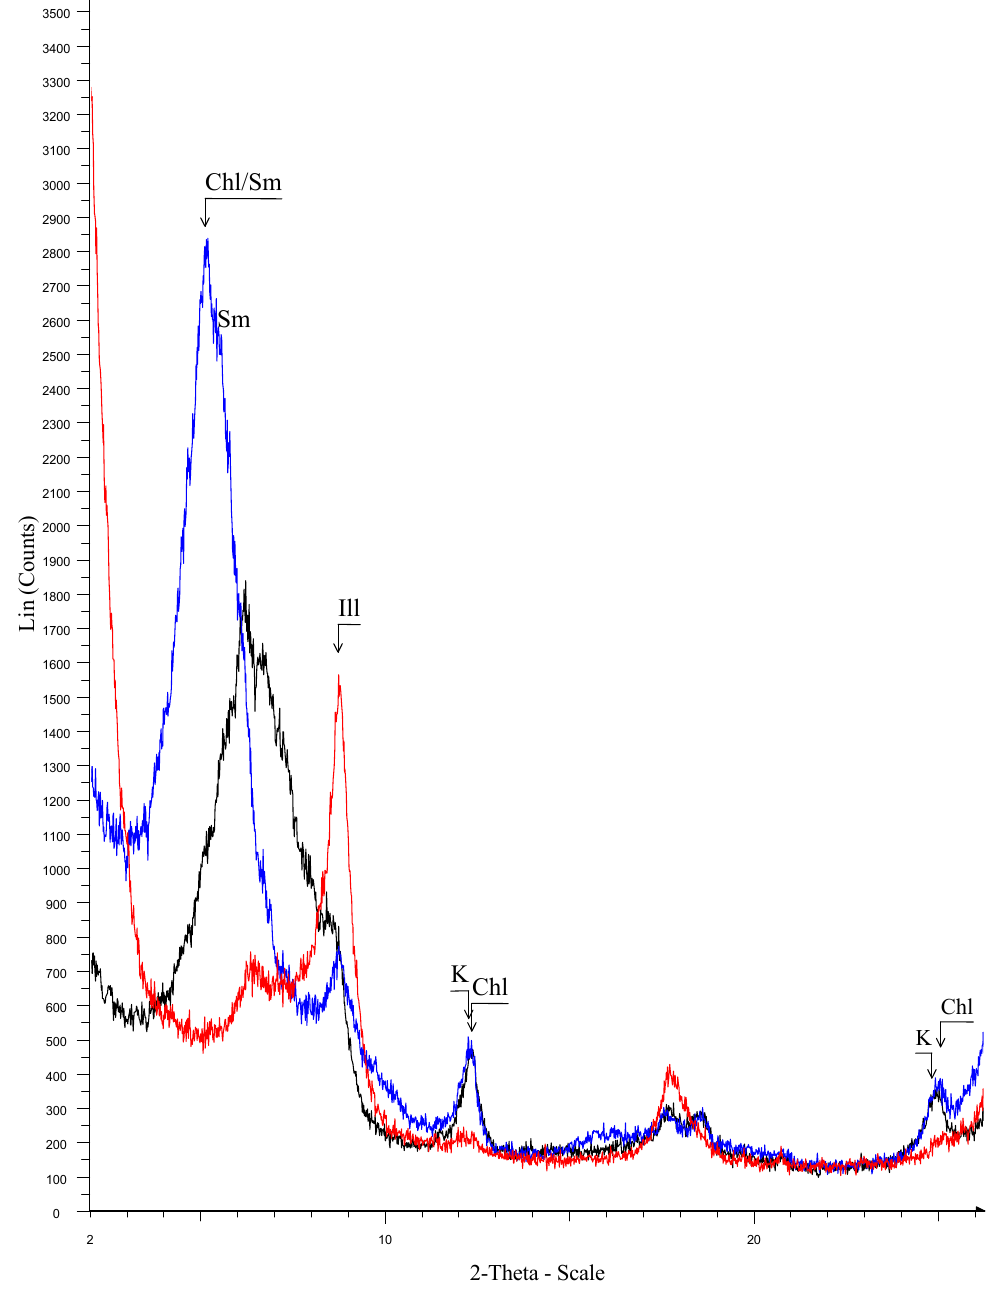
Figure A6. Representative composite diffractogram of SE clayey raw materials established according to the clay minerals content revealed from the <2 μ m fraction. The diffraction pattern of each preparation is intentionally equally displaced in respect to the Y axis to obtain a better visual. Abbreviations: Sm = Smectite, Chl = Chlorite, K = Kaolinite, Ill = Illite, Chl/Sm = Chlorite/Smectite. Red line = heated at 490 °C; Blue line = ethylene-glycol solvation; Black line = air dried.